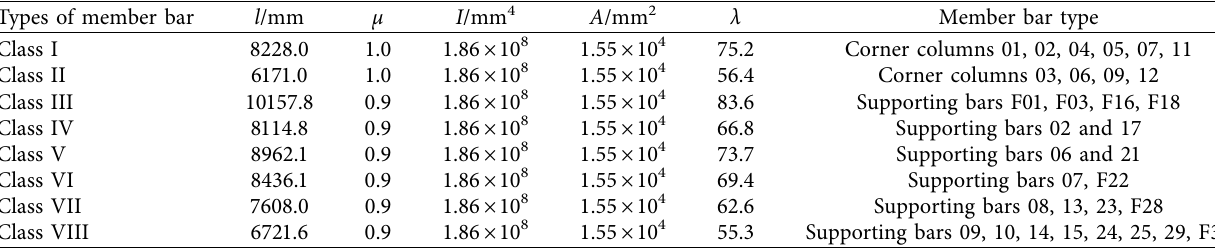
Table 1: Parameters of the members.